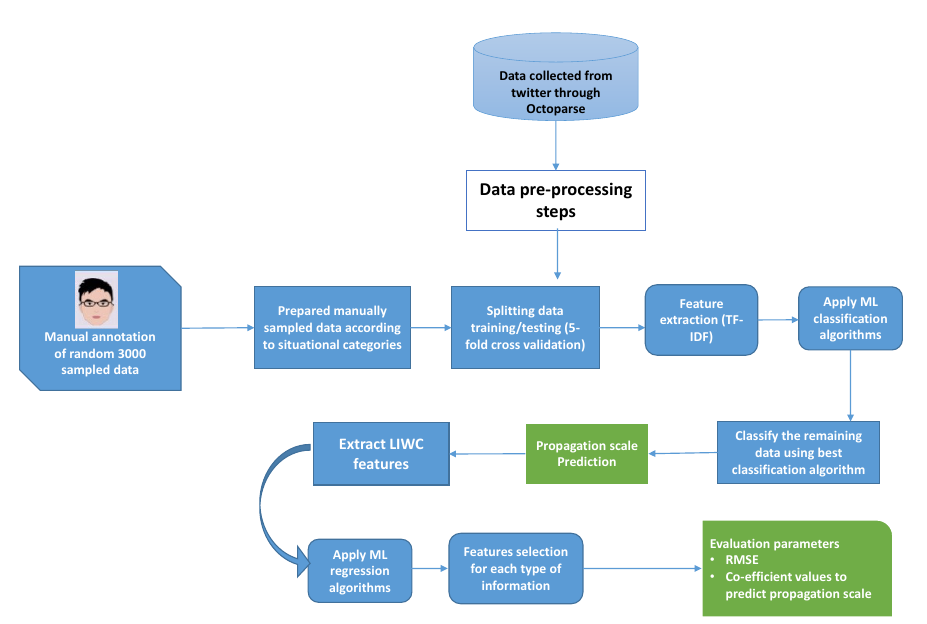
Figure 2. A graphical workflow of the proposed framework describing all the steps to determine the propagation scale of situational